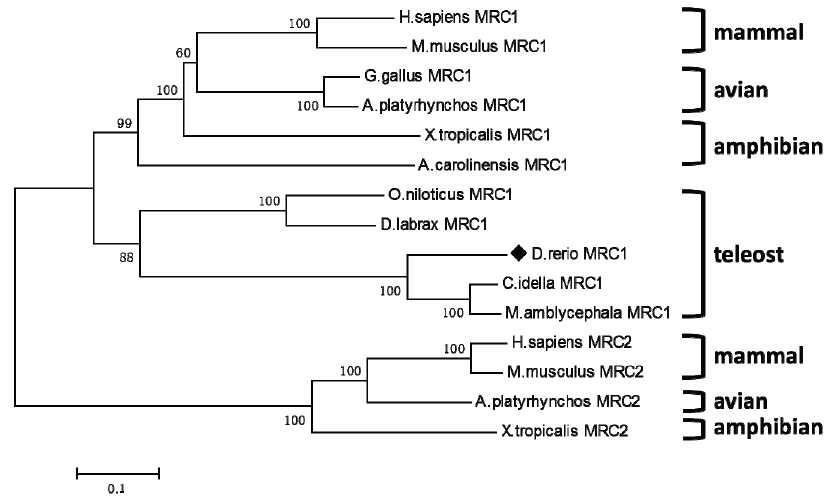
Figure 2. Phylogenetic tree of MR from Danio rerio (KP172154) and other species were constructed using Molecular Evolutionary Genetics Analysis (MEGA) 4.0 with neighbor-joining method. Numbers of each node indicated the percentage of bootstrapping of a 1000 replications. Danio rerio MRC1 (KP172154) was marked with ♦ . The protein sequences used for phylogenetic analysis were Anolis carolinensis MRC1 (XM_003222081.1), Xenopus tropicalis MRC1 (XM_002939002.2), Anas platyrhynchos MRC1 (EOB05991.1), Mus musculus MRC1 (NM_008625.2), Homo sapiens MRC2 (NM_006039.4), Mus musculus MRC2 (NM_008626.3), Anas platyrhynchos MRC2 (XM_005030646.1), Xenopus tropicalis MRC2 (NM_001097247.1), other sequences were shown in the legend of Figure 1.